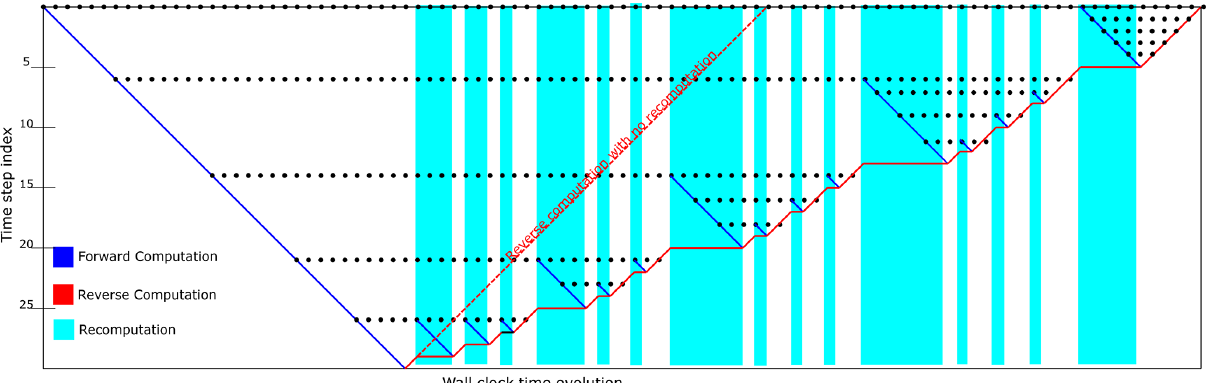
Figure 2. Schematic of the checkpointing strategy. Wall-clock time is on the horizontal axis, while the vertical axis represents simulation time. The blue line represents forward computation. The dotted red line represents how the reverse computation would have proceeded after the forward computation if there had there been enough memory to store all the necessary checkpoints. Checkpoints are shown as black dots. The reverse computation under the checkpointing strategy is shown as the solid red line. It can be seen that the reverse computation proceeds only where the results of the forward computation are available. When not available, the forward computation is restarted from the last available checkpoint to recompute the results of the forward – shown here as the blue-shaded regions.